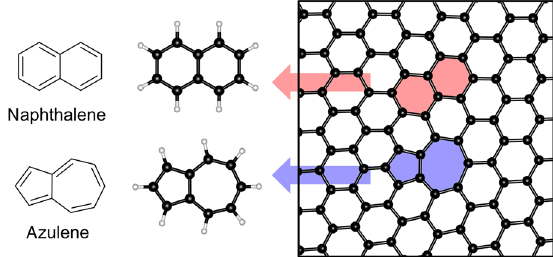
FIG. 1. Right, graphene lattice with an embedded nonalternant 5-7 defect, highlighted in blue. If this structural element is cut out of graphene and terminated with hydrogen atoms, the resulting molecule is azulene, shown on the left. Its isomer naphthalene serves as the complementary model system for the regular, alternant 6-6 structure, highlighted in